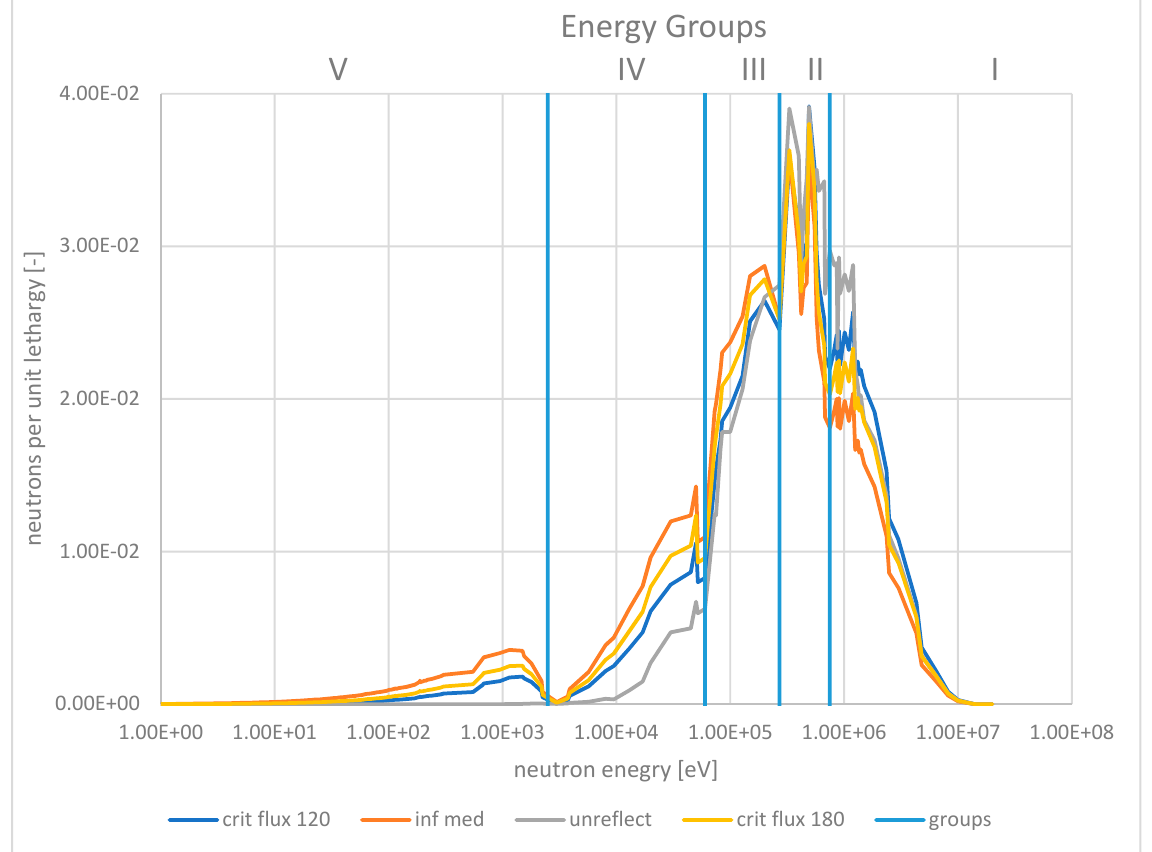
Figure 12. Neutron flux spectrum for the reflected and the unreflected core as well as for different axial leakage approximation (infinite medium, 120 cm core height, and 180 cm core height) using different core heights with added neutron group structure for the spatial flux distribution analysis.